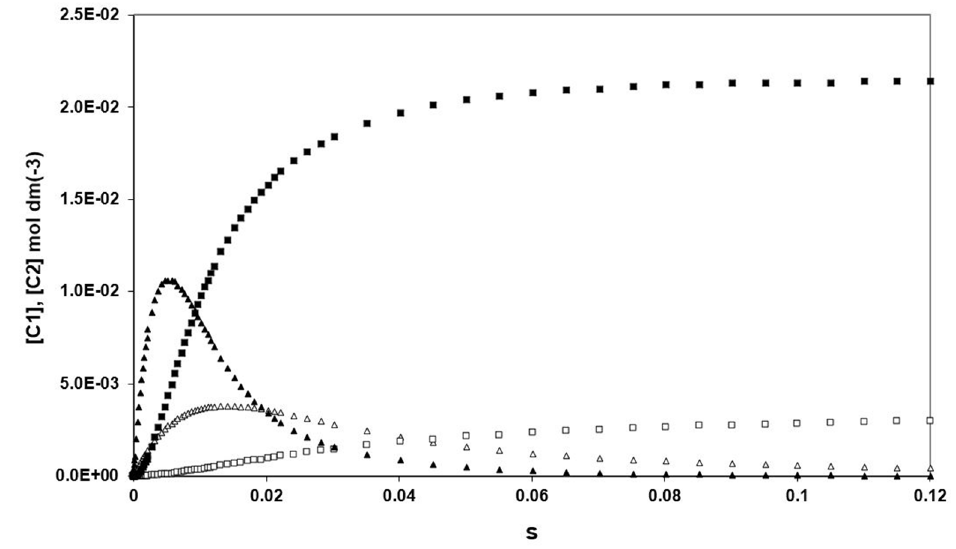
Figure 5. Kinetics of [C 1 ] and [C 2 ] in the early phase. [C 1 ] (triangles), [C 2 ] (squares); [H 2 O 2 ] o = 0.5 mol dm − 3 (empty symbols); [H 2 O 2 ] o = 3.5 mol dm − 3 (full symbols). Other parameters as in Figure 2.